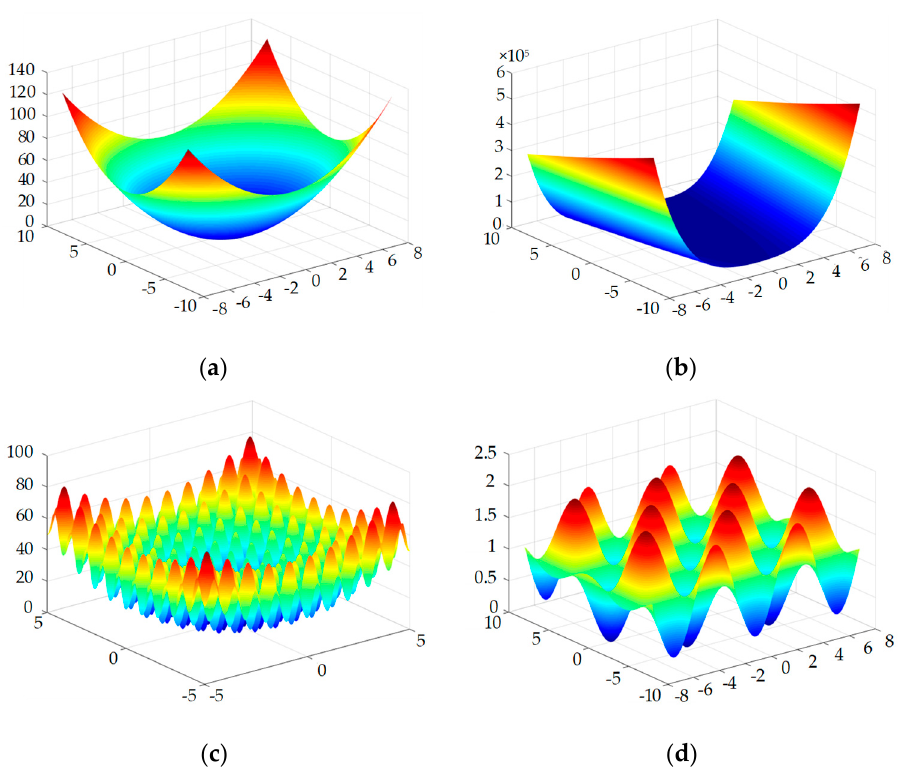
Figure 1. Three-dimensional map of the four functions: ( a ) Sphere function; ( b ) Rosenbrock function; ( c ) Rastrigin function; ( d ) Griewank function.